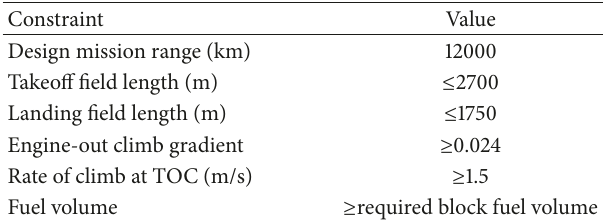
Table 4: Optimization problem